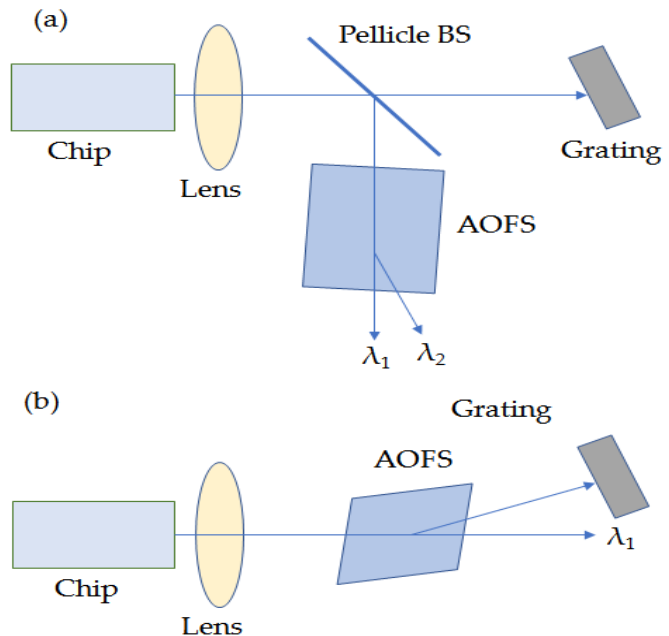
Figure 4. Two tunable structures of ECQCL: ( a ) ECQCL with extra-cavity AOFS, ( b ) ECQCL with intra-cavity AOFS. BS: Beam splitter.